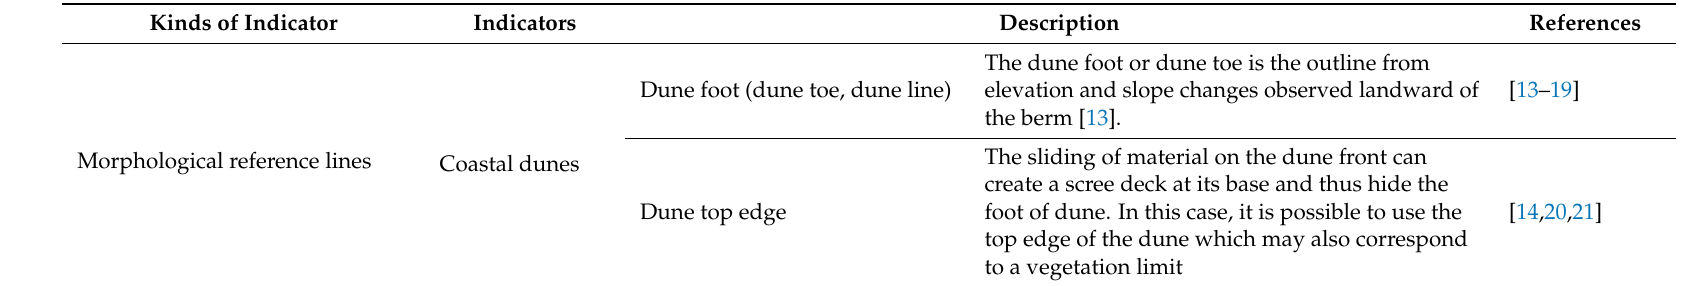
Table 1. Summary of shoreline indicators (adapted from